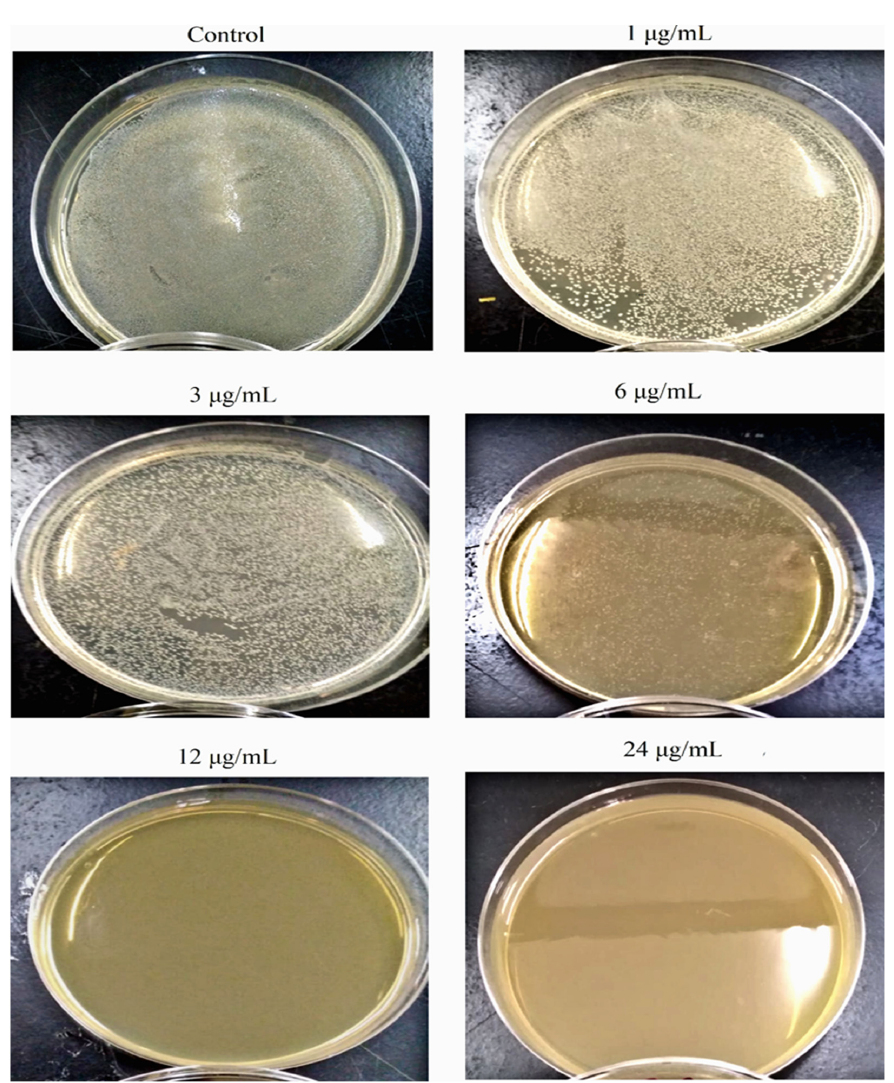
Figure 6. Photograph of S. aureus grown on Muller Hinton agar as a function of AgNPs concentrations.